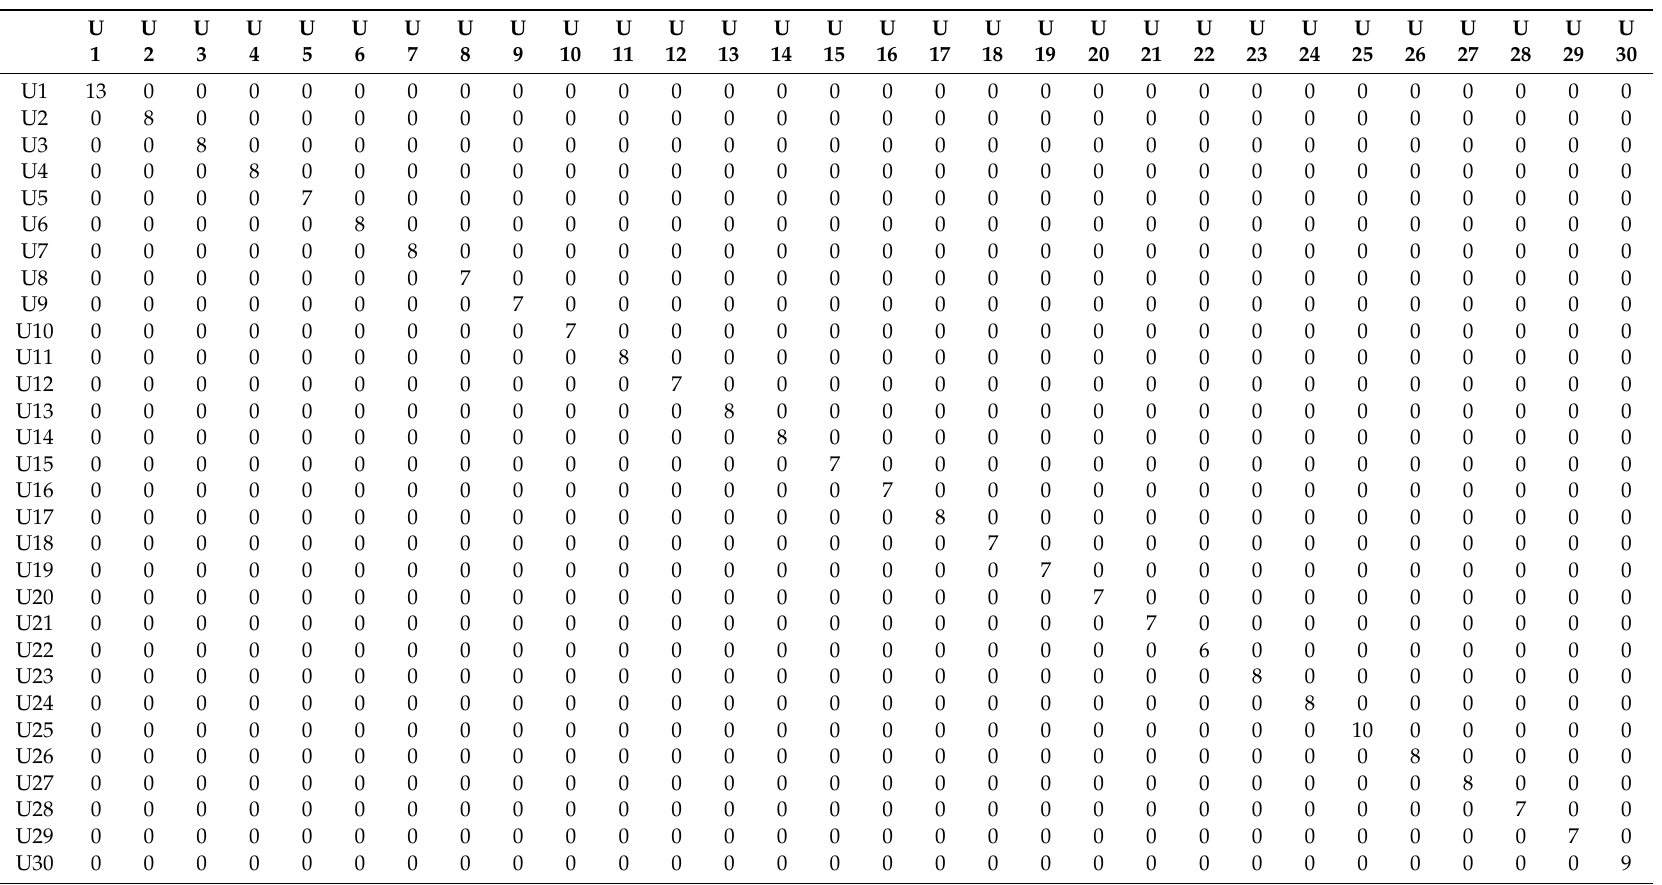
Table 3. Confusion matrix of user identification for walking activity in the HAR